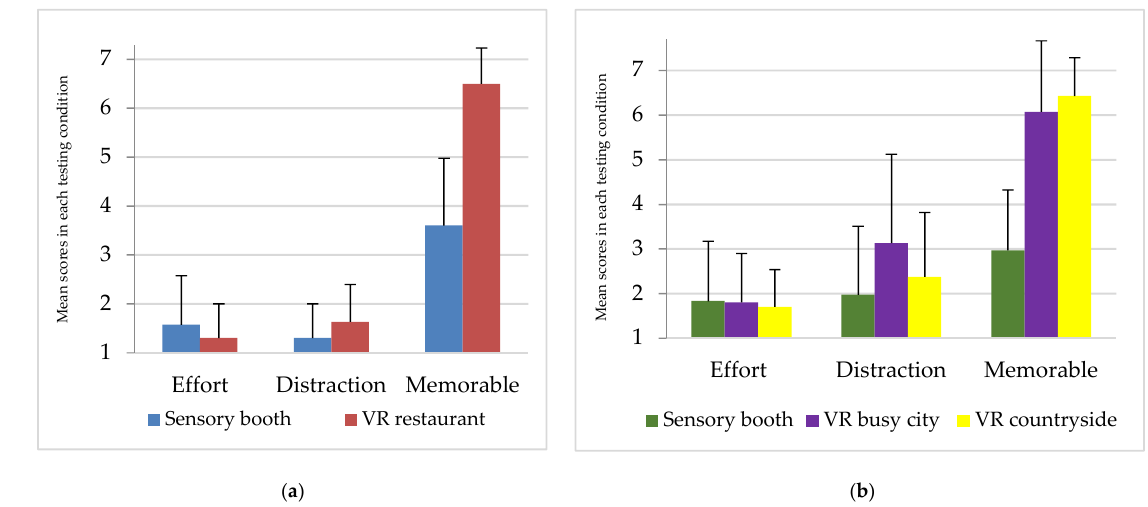
Figure 3. Participants mean scores and standard deviations for beef ( a ) and chocolate ( b ) in each testing condition. The questions asked were: Do you think testing the product in the surrounding environment requires much effort? Do you think the surrounding environment distracted you from performing the task? Was the sensory testing experience memorable? Responses recorded on a 7-point scale where 1 = not at all and 7 = very much.